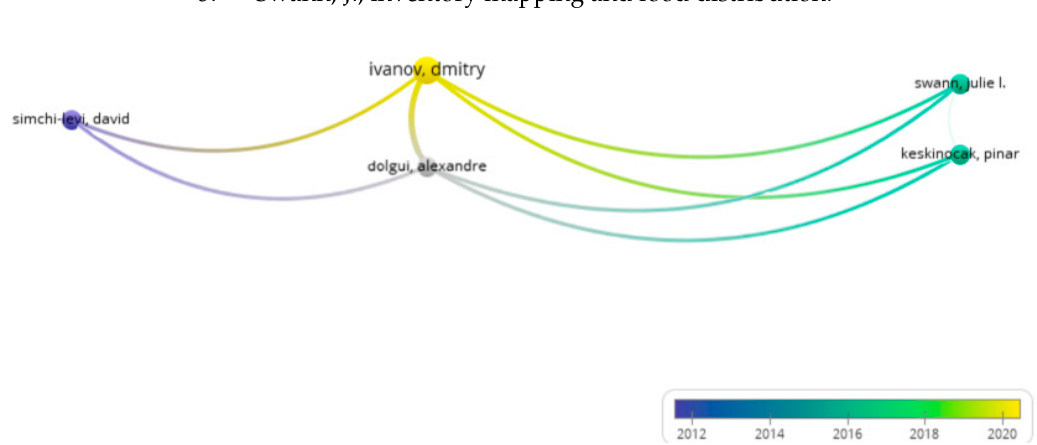
Figure 5. Network Author Analysis.